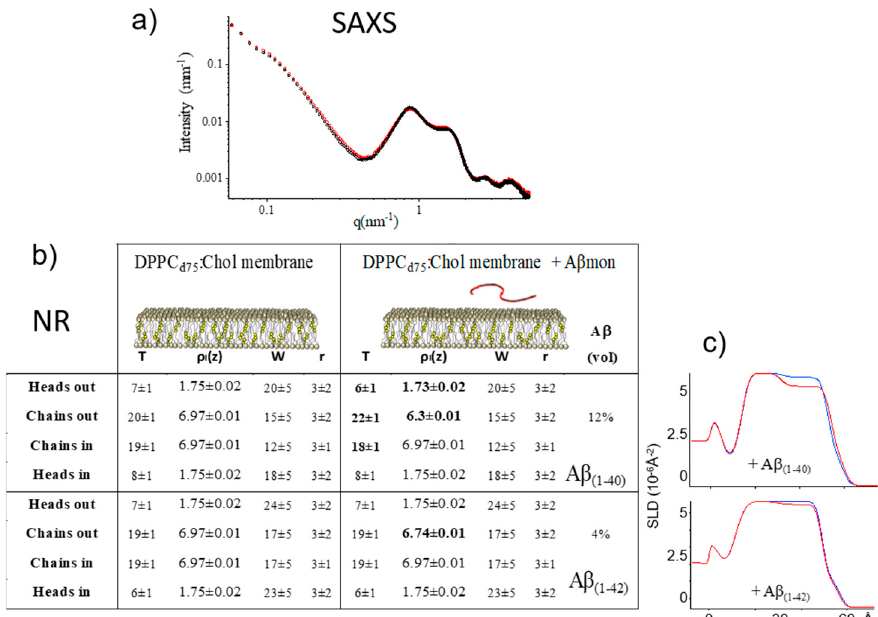
Figure 4. PC-phospholipid:cholesterol membranes exposed to A β monomers. ( a ) SAXS results. SAXS spectra of DPPC:Chol vesicles before (black diamonds) and after 1 h incubation with A β mon(1–42) (red squares) T = 26 °C. Incubation with peptide was done for 1 h at T = 50 °C. NR results. ( b ) Table. Layers parameters, as deduced by the fits of NR spectra, of a single deposited DPPC d75 :Chol membrane (10:1.25 mol/mol fraction), before (left section) and after (right section) interaction with A β mon(1–40) and A β mon(1–42) . Layers thickness (Å), SLD (10 − 6 Å − 2 ), solvent penetration (% in volume), roughness of interfaces (Å). ( c ) SLD profiles obtained by the best NR data fit of the DPPC d75 :Chol (10:1.25 mol/mol) membranes before (blue) and after (red) interaction with A β mon(1–40) (upper panel) and A β mon(1–42) (lower panel). T = 22 °C. NR spectra are reported in the Figure S9. After incubation, full characterization of the membranes in three solvents was performed.